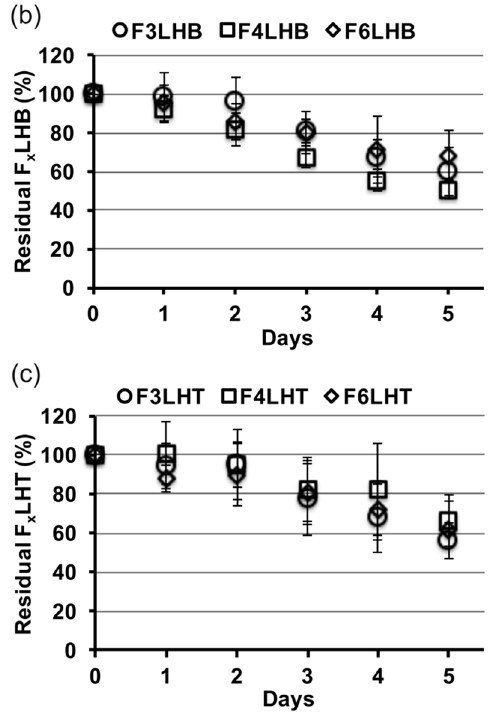
Figure 3. Residual F x LHD monomer in the biodegradation solution incubated with 0.35 g · L − 1 HSA at pH 8.8 ( n = 9, ± SD), arranged based on the nature of diol linkers: ( a ) hexane diol (F x LHH), ( b ) butane diol (F x LHB), and ( c ) triethylene glycol (F x LHT).